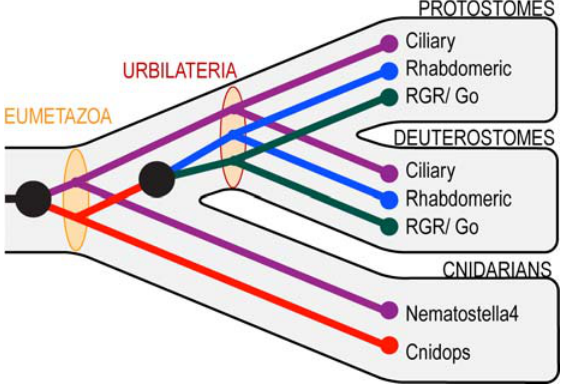
Figure 5. Our preferred hypothesis for opsin phylogeny (figure 4A) reconciled to a conservative view of metazoan phylogeny. Black circles indicate gene duplication events. Tan ovals indicate the opsin complement at key nodes in metazoan phylogeny. By this hypothesis, both ciliary and cnidops opsins were present in the eumetazoan ancestor of Cnidaria + Bilateria while rhabdomeric and G o opsins evolved by gene duplication prior to the evolution of bilaterian animals, but not